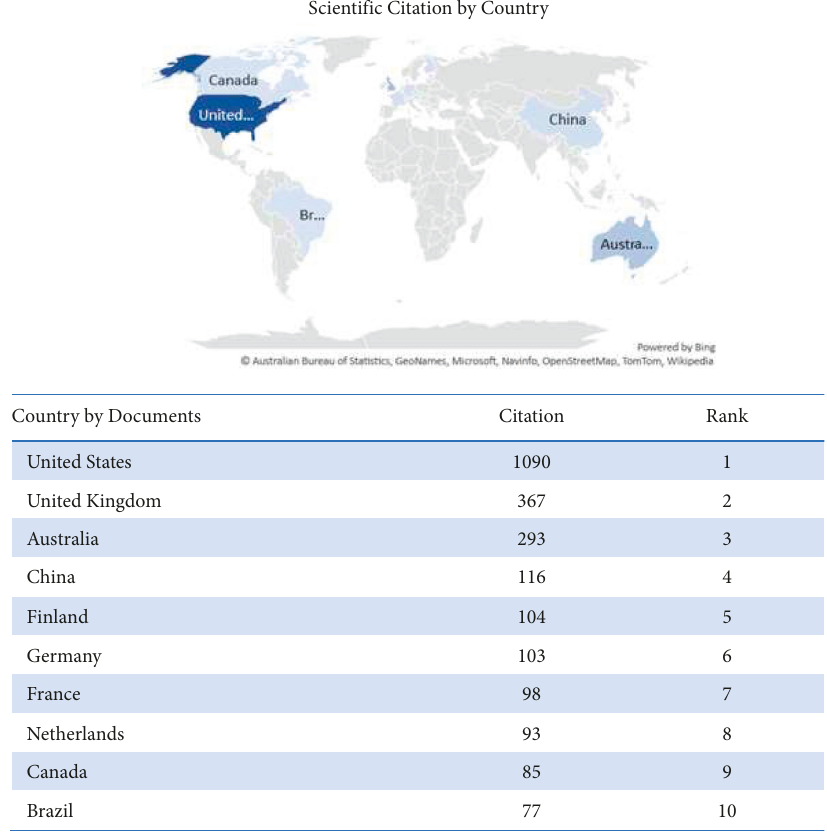
Figure 5: Documents by citations.